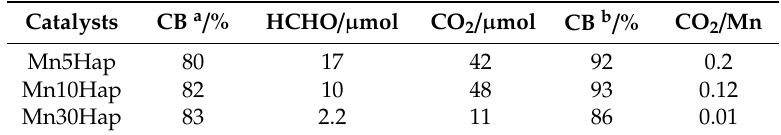
Table 4. Carbon balance levels.